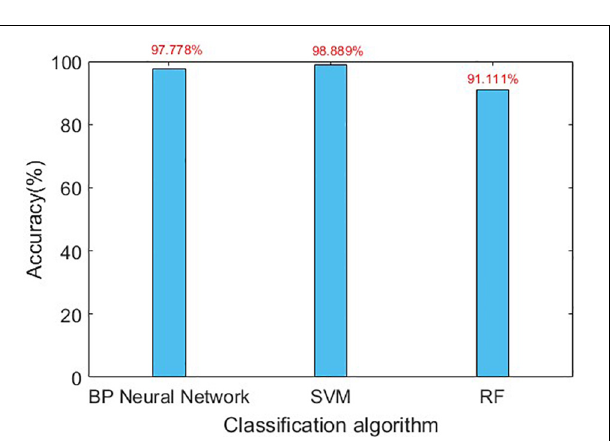
FIGURE 12 | Accuracy of three algorithms in Romberg’s test.